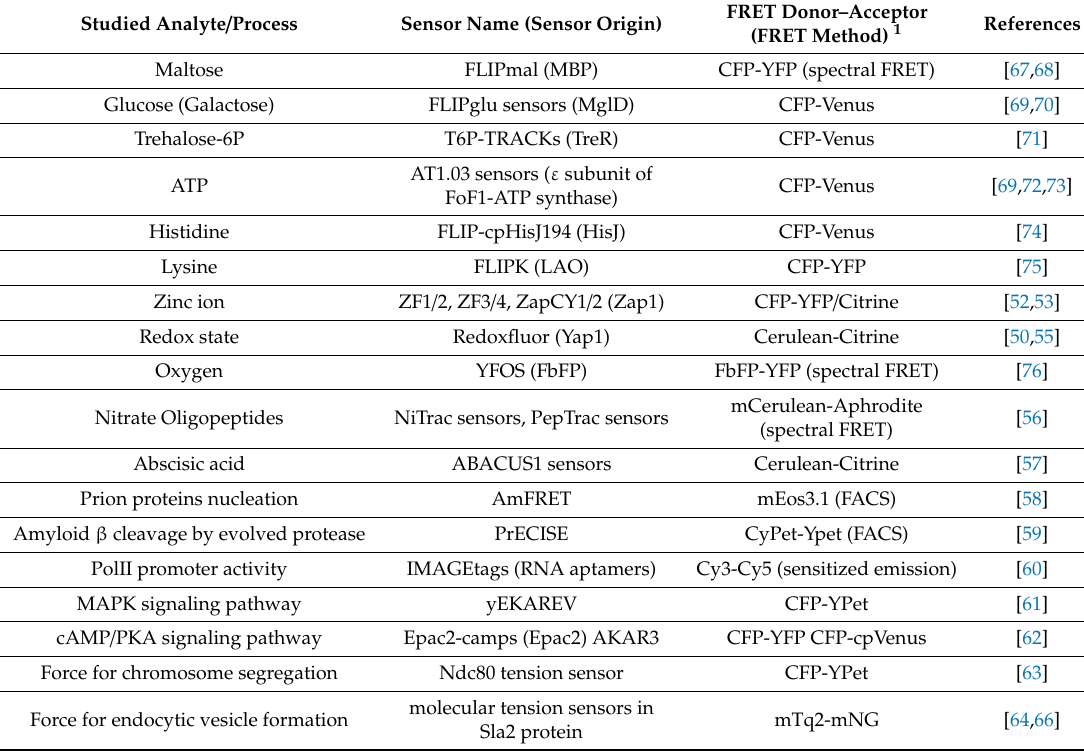
Table 2. FRET biosensors in